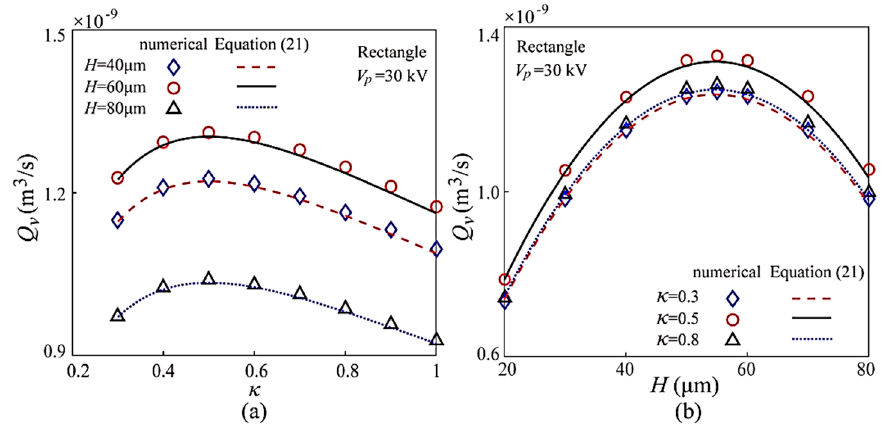
Figure 9. Effect of daughter-to-parent channel width ratio ( a ) and channel height ( b ) on the flowrate of EOF in the Y-shaped rectangular microchannels.